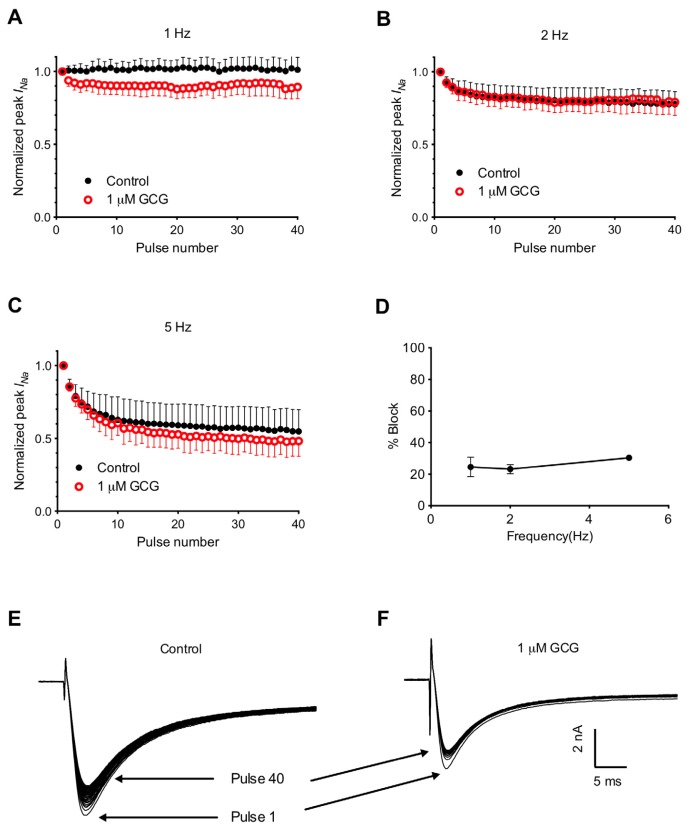
The frequency-dependen blockage effect on tetrodotoxin-resistant Na+ currents. Whole-cell currents were evoked by 40-step depolarization commands (holding potential −120 mV; test potential −10 mV; pulse duration 40 ms). (A–C) The ratios of the current amplitude at the testing pulse versus the 1st pulse are shown at 1 Hz (A), 2 Hz (B) and 5 Hz (C) in the absence (filled circle) and presence (unfilled circle) of 1 μM GCG; (D) The percentage block of 1 μM GCG on tetrodotoxin-resistant Na+ currents at different frequencies (n = 5 for each frequency). No frequency-dependent effect was observed (ANOVA, p > 0.05). (E,F) Representative recordings at 2 Hz in the absence (E) or presence (F) of 1 μM GCG. Arrows mark traces for pulse 1 and pulse 40.